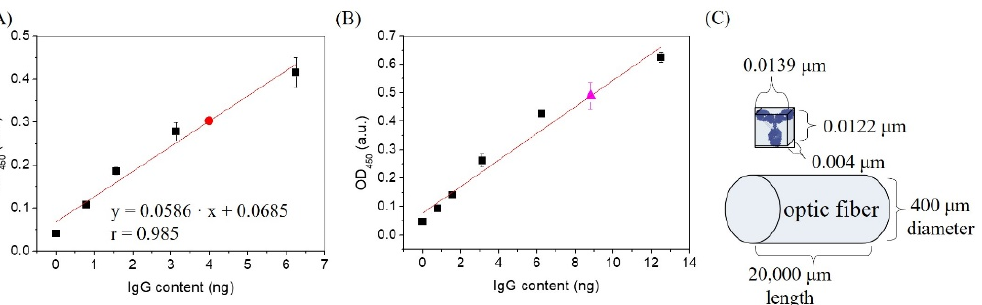
Figure 4. Calibration curves for quantitation of detection antibody and capture antibody immobilized on ( A ) AuNP and ( B ) sensing fiber, respectively. The black square data points represent the calibration points. The red circle and magenta triangle data points show the values obtained for the amount of antibody molecules immobilized on ( A ) AuNP and ( B ) sensing fiber, respectively. ( C ) Size estimation of an antibody.